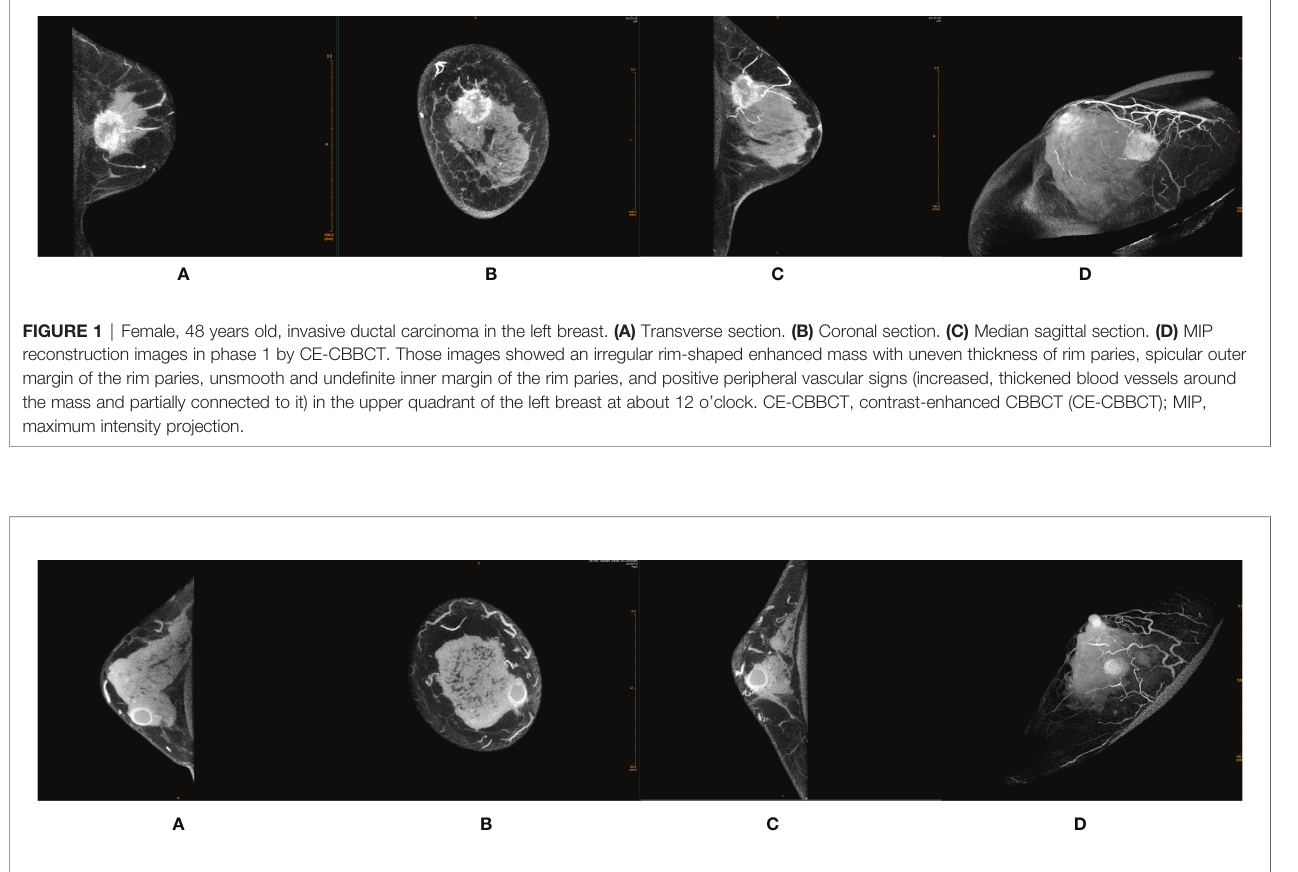
FIGURE 2 | Female, 32 years old, cystic fi brosis with in fl ammation in right breast. (A) Transverse section. (B) Coronal section. (C) Median sagittal section. (D) MIP reconstruction images in phase 1 by CE-CBBCT. Those image showed a circular rim-shaped enhanced mass with uniform thickness of rim paries, smooth and de fi nite inner and outer margin of the rim paries, and negative peripheral vascular signs (without obvious increased and thickened blood vessels around the mass) in the inner and lower quadrant of the right breast at about 4 o ’ clock. CE-CBBCT, contrast-enhanced CBBCT (CE-CBBCT); MIP, maximum intensity